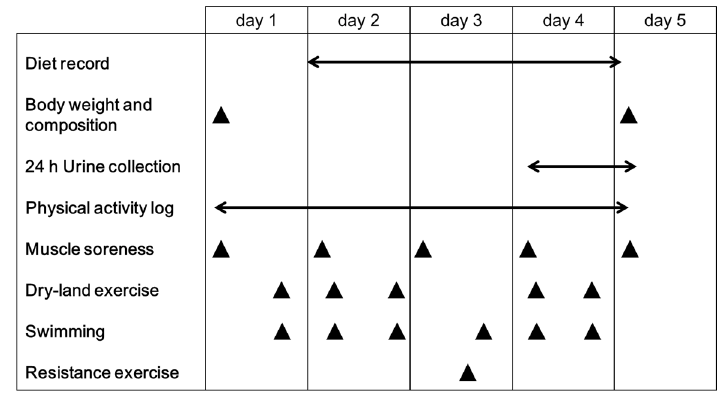
Figure 1. Schematics of the experimental protocol.